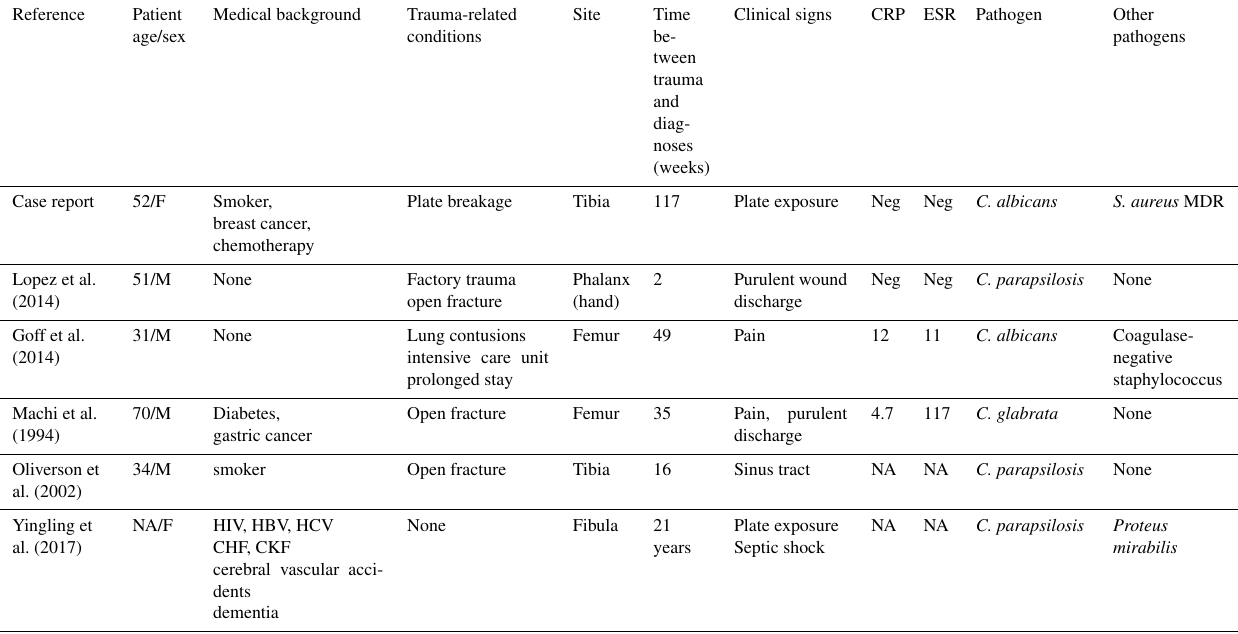
Table 1. Clinical features of reported cases of CFRI in the literature. MDR: multi-drug resistant; CHF: congestive heart failure; CKF: chronic kidney failure. NA – not available.